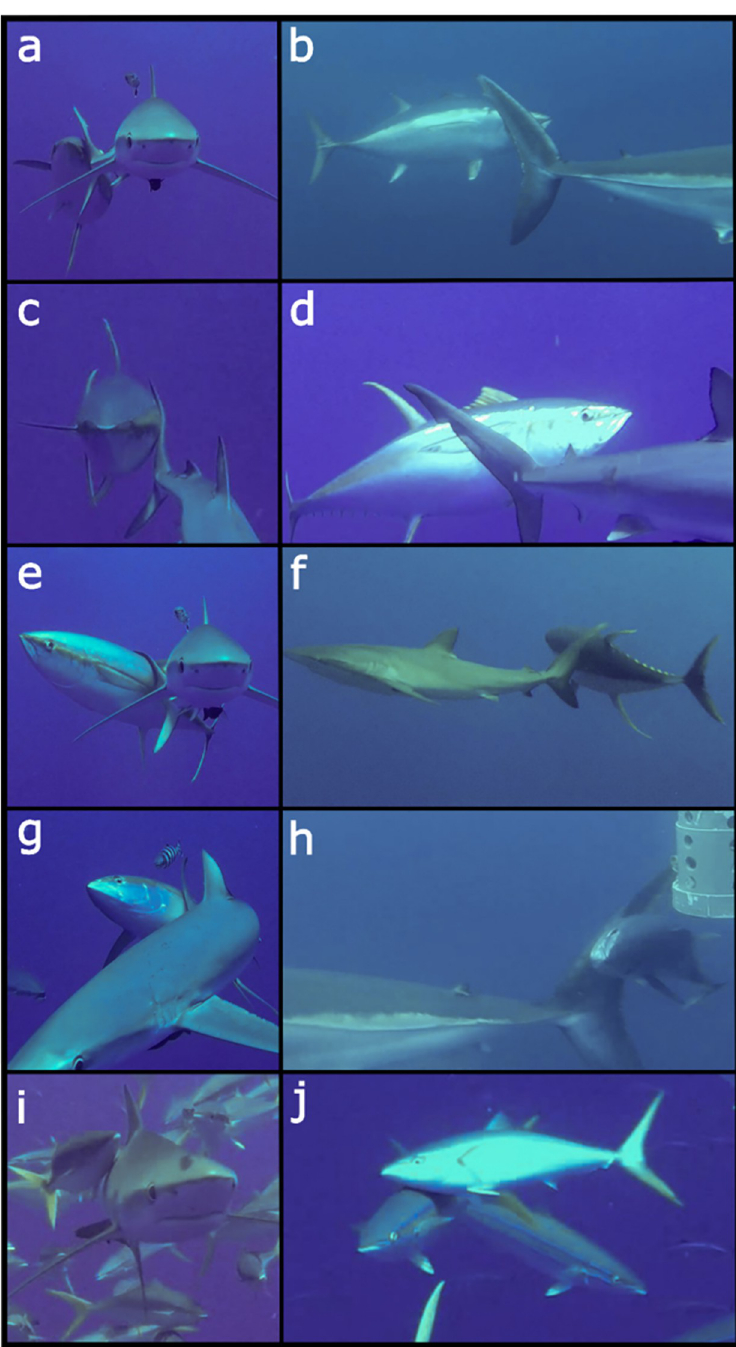
Fig 1. Example images of some of the scraping interactions observed. Anterior and lateral views of scrapees scraping their head (a, b), lateral surface/pectoral fin (c, d), dorsal surface (e, f), and ventral surface (g,h) on the posterior caudal margin of sharks. i) and j) show scrapers respectively scraping their ventral surface on the lateral surface of a shark and gill cover on the dorsal surface of a conspecific. Scraper-scrapee pairs are; yellowfin tuna Thunnus albacares —blue shark Prionace glauca at Ascension Island (a, c, d, e, g), southern bluefin tuna Thunnus maccoyii —shortfin mako shark Isurus oxyrhinchus at Recherche Archipelago (b, h), yellowfin tuna—silky shark Carcharhinus falciformis , Revillagigedo Archipelago (f), rainbow runner Elagatis bipinnulata —blue shark, Ascension Island (i), and rainbow runner-rainbow runner, Ascension Island (j).